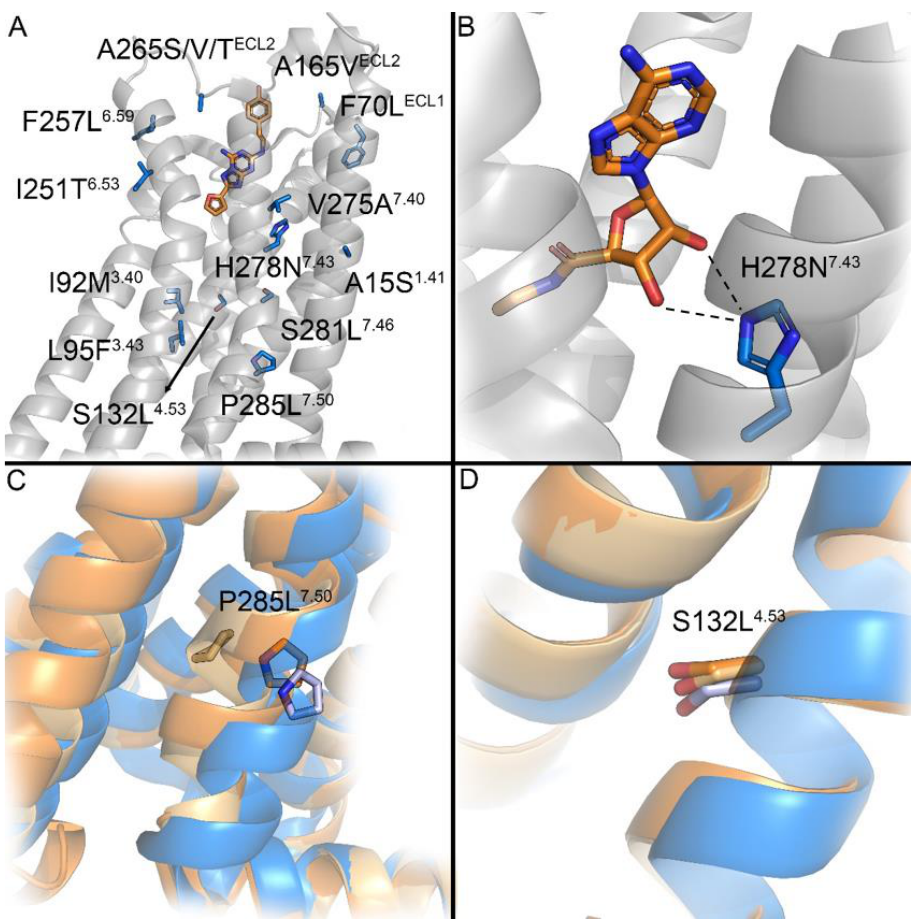
Figure 7. ( A ) Overview of all mutations investigated in this work, mapped on the inactive structure of the receptor (blue); antagonist ZM241385 is shown in orange. ( B ) Residue H278 was involved in agonist binding (NECA; orange), forming hydrogen bonds (dashed lines) with the ribose moiety. ( C ) P285 underwent extensive conformational rearrangement in the active-like structure (light orange). The active structure (orange) was closer to the inactive structure. ( D ) Residue S132 did not undergo extensive rearrangement when comparing inactive, active-like, and active structures.